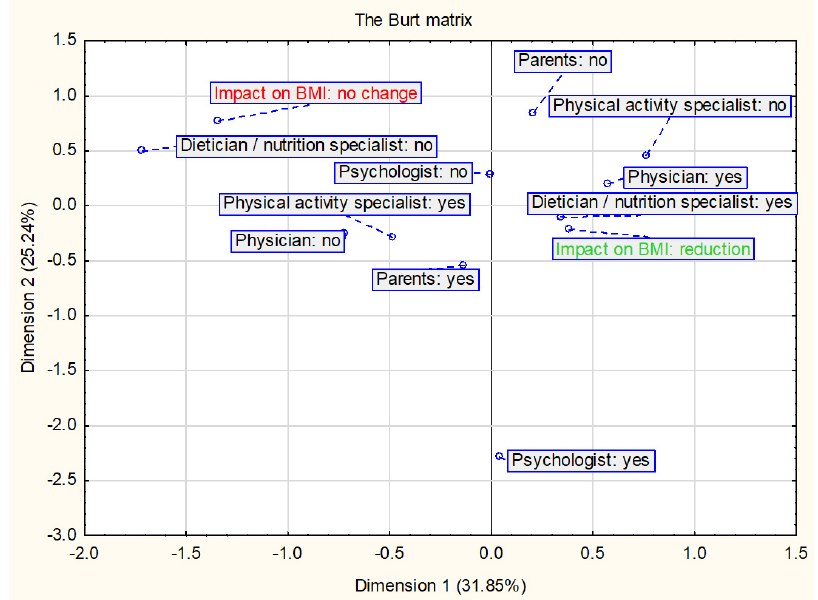
Figure 5. Presentation of the correspondence analysis results defining the relationship between the changes in BMI and/or BMI z-score and parental and therapeutic team involvement ( n = 18 ).